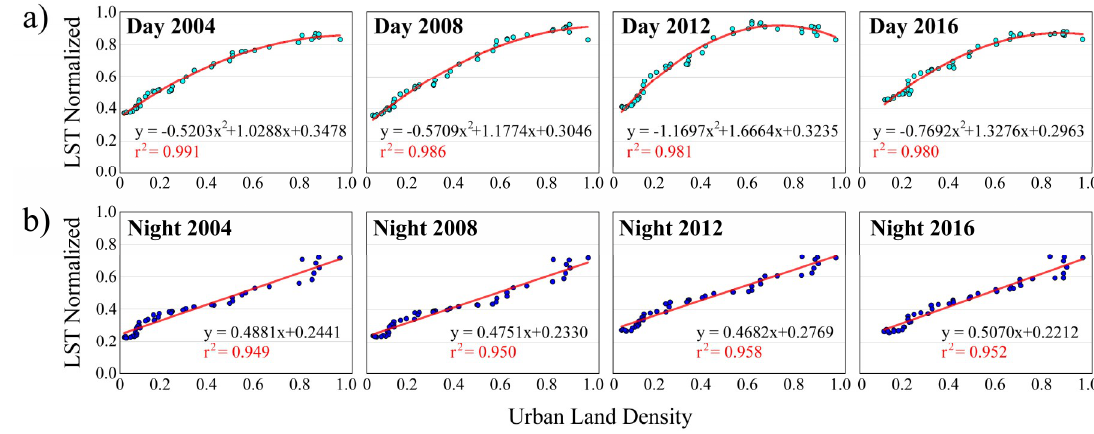
Figure 8. Urban land density data versus LST n computed in each concentric ring. Regression function and r 2 are reported for each year. ( a ) daytime; ( b ) night-time.